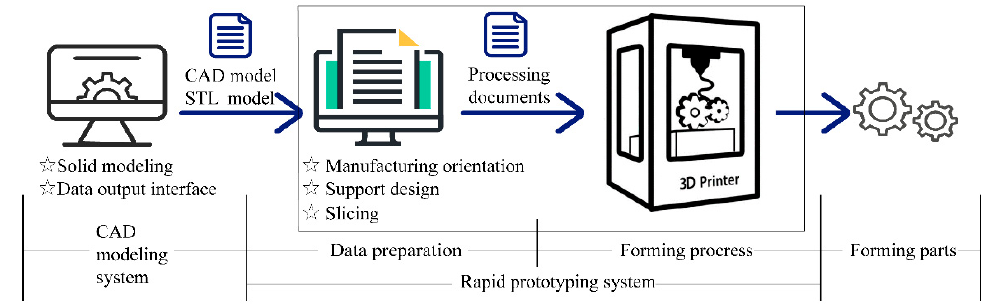
Figure 5. Process flow chart of AM.